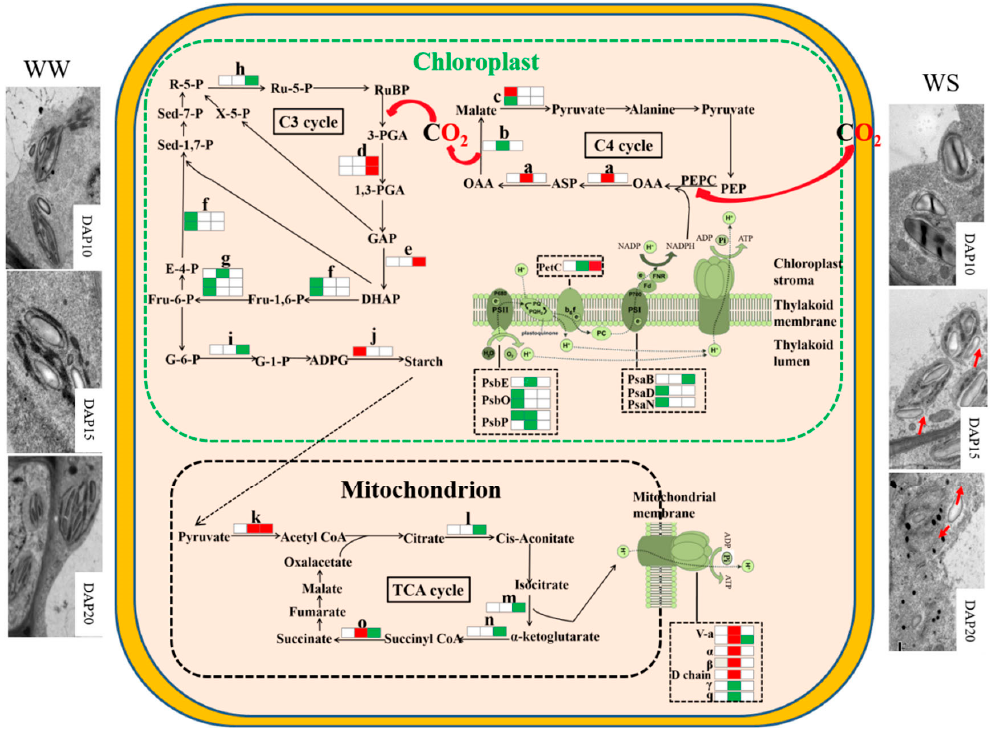
Figure 6. The pathways of proteomic mechanisms in the pod wall under drought stress. a, Aspartate aminotransferase; b, malate dehydrogenase; c, malic enzyme; d, phosphoglycerate kinase; e, triosephosphate isomerase; f, fructose-1, 6-bisphosphate aldolase; g, fructose-1, 6-bisphosphatase; h, ribose-5-phosphate isomerase; i, glucose-6-phosphate isomerase; j, starch synthase; k, pyruvate dehydrogenase E1 beta subunit; l, aconitate hydratase; m, isocitrate dehydrogenase (NADP); n, E1 subunit-like 2-oxoglutarate dehydrogenase, o, ATP-citrate lyase/succinyl-CoA ligase. Three squares from left to right represent WS10 vs. WW10, WS15 vs. WW15, and WS20 vs. WW20, respectively. The red squares represent significant upregulation at the 0.05 probability level. The green squares represent significant low-regulation at the 0.05 probability level. The white squares represent no significance. The red arrows show the damaged part of the chloroplast membrane in the pod wall under WS. Define the Dotted black arrow if possible